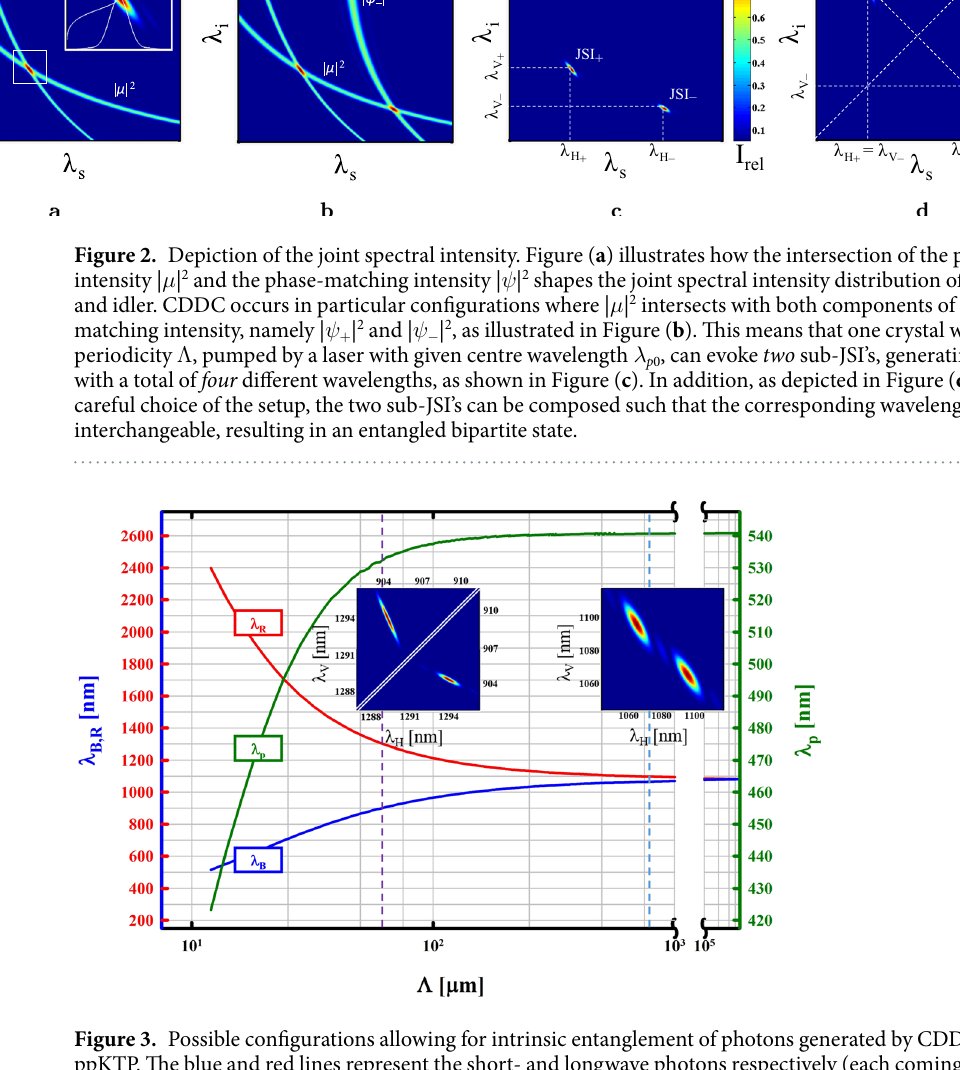
λ B and R are approaching each other